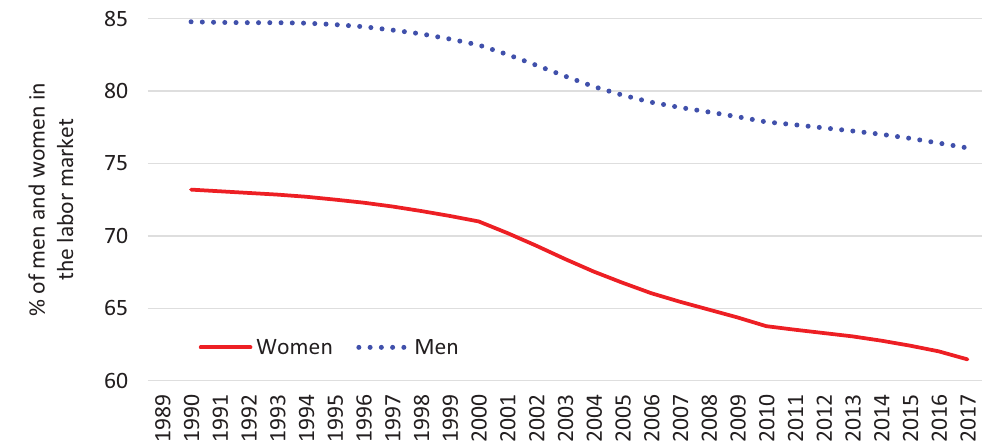
Figure 1. Labor force participation rate by gender: China 1990–2017. Labor force participation rate, male (percentage of male population ages 15 + ; modeled ILO estimate). Source: The World Bank (n.d.).